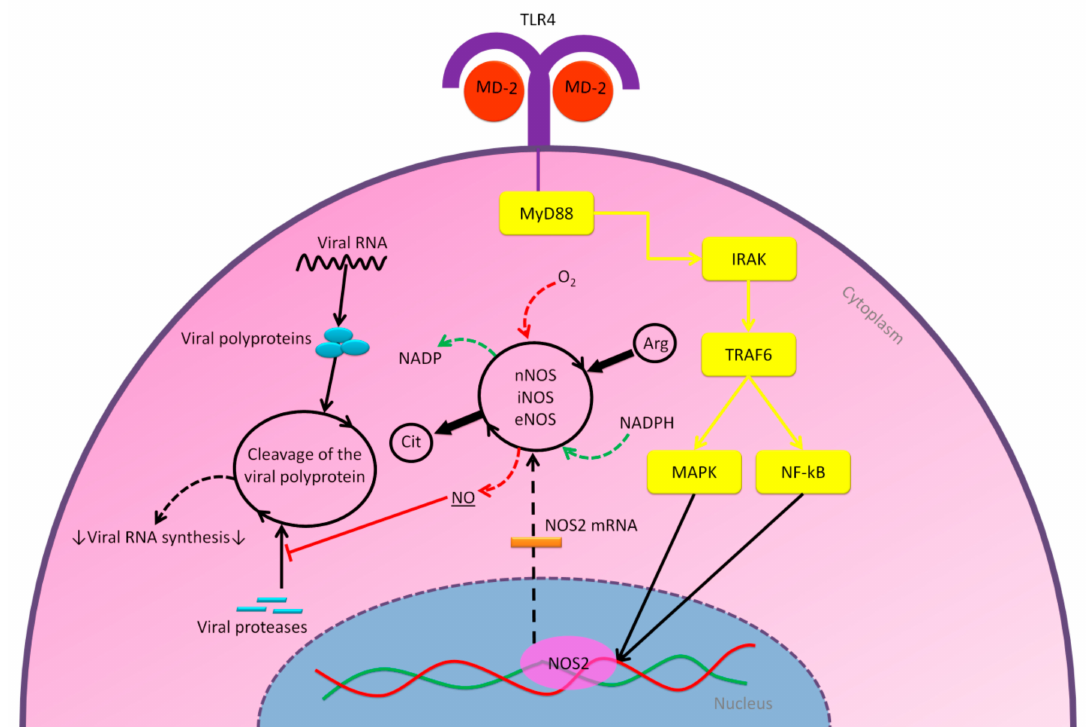
Figure 6. The hypothesized mechanisms of action for NO antiviral e ff ect through the MD-2 / TLR4 signaling axis, again implicated in the viral infection at the intracellular level. The MD-2 / TLR4 signals activate the transcription of the nitric oxide synthase 2 (NOS2) gene through activation of MAPK and NF-kB. This activation results in expression of NOS2 mRNA to produce NOS enzymes that are responsible for producing NO by the conversion of l -arginine (Arg) into l -citrulline (Cit), with existing nicotinamide adenine dinucleotide phosphate (NADPH) and oxygen (O 2 ). There are three isoforms from NOS enzymes that produce NO; neuronal NOS (nNOS), inducible NOS (iNOS), and endothelial NOS (eNOS); each of them is expressed in di ff erent cell types. In the cell infected by a virus, NO might inhibit viral protease enzymes by blocking their cleavage ability of viral polyproteins. This process would inhibit the synthesis of viral RNA, and thus inhibit viral